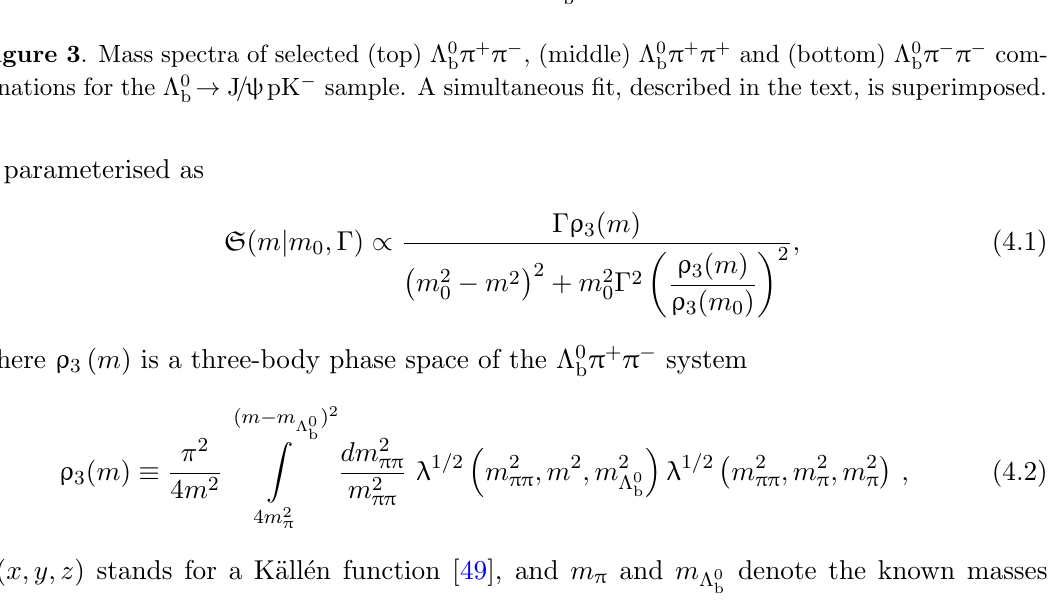
(cid:25) (cid:0) (cid:25) (cid:0) com- b